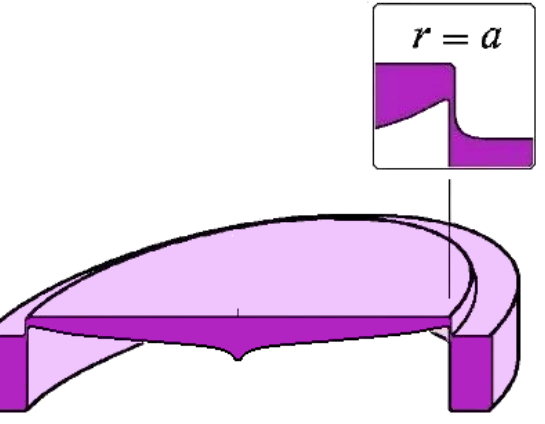
Figure 2. Schematic of a tulip-like VCM with central truncated stem showing the plate-collarette-ring geometry.